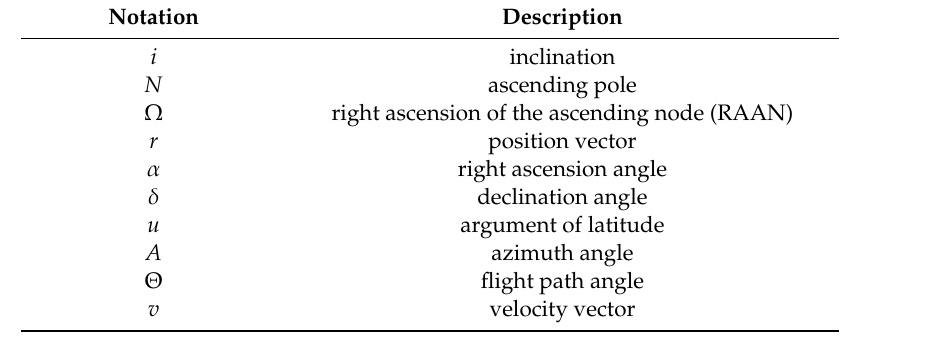
Table A1. Parameters used in the Figure 2.